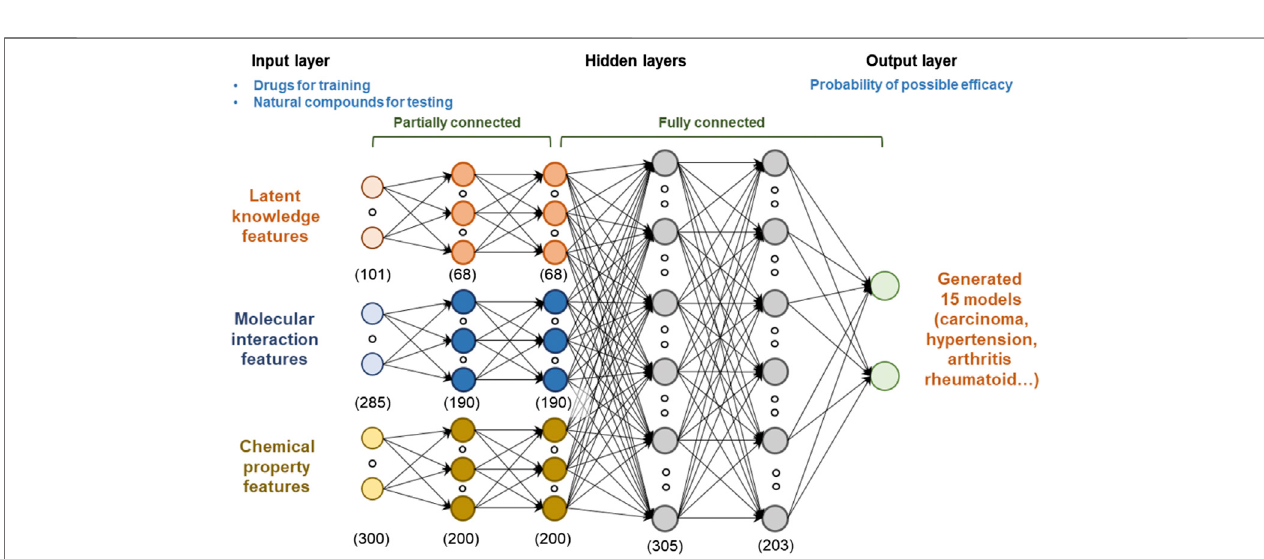
FIGURE3| Architectureofthedeeplearningmodelforpredictingthepotentialeffectsofnaturalcompounds.Weusedlatentknowledge,molecularinteraction,and chemical property features as the inputs of the model, and each feature consisted of 101, 241, and 300 fi xed-length numeric vectors. To capture the high-level representation of each feature, we applied both partially connected and fully connected neural network structures. The model was trained based on the extracted features and veri fi ed indication information of drugs. Models were generated for 15 diseases, respectively. Finally, we predicted the potential medicinal effects of natural compounds based on the trained